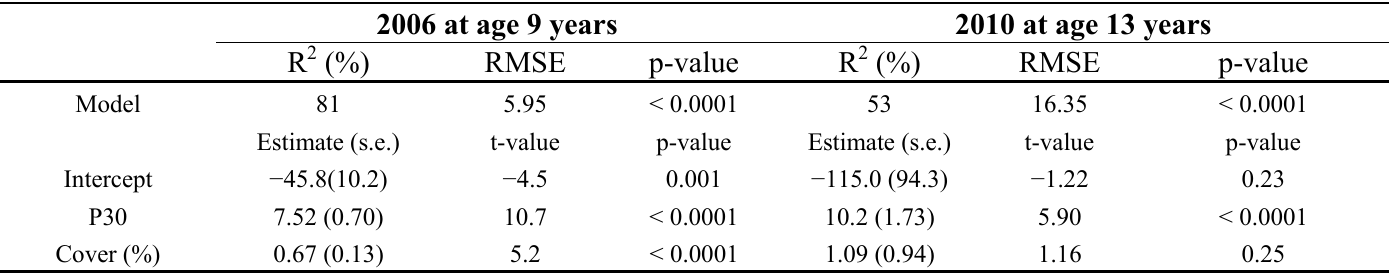
Table 7. Multiple regression relationship between modelled above ground (crown plus stem) carbon and LiDAR percentile height (P30) and cover (%), based on 36 plots in three trials measured in 2006 and 2010 at